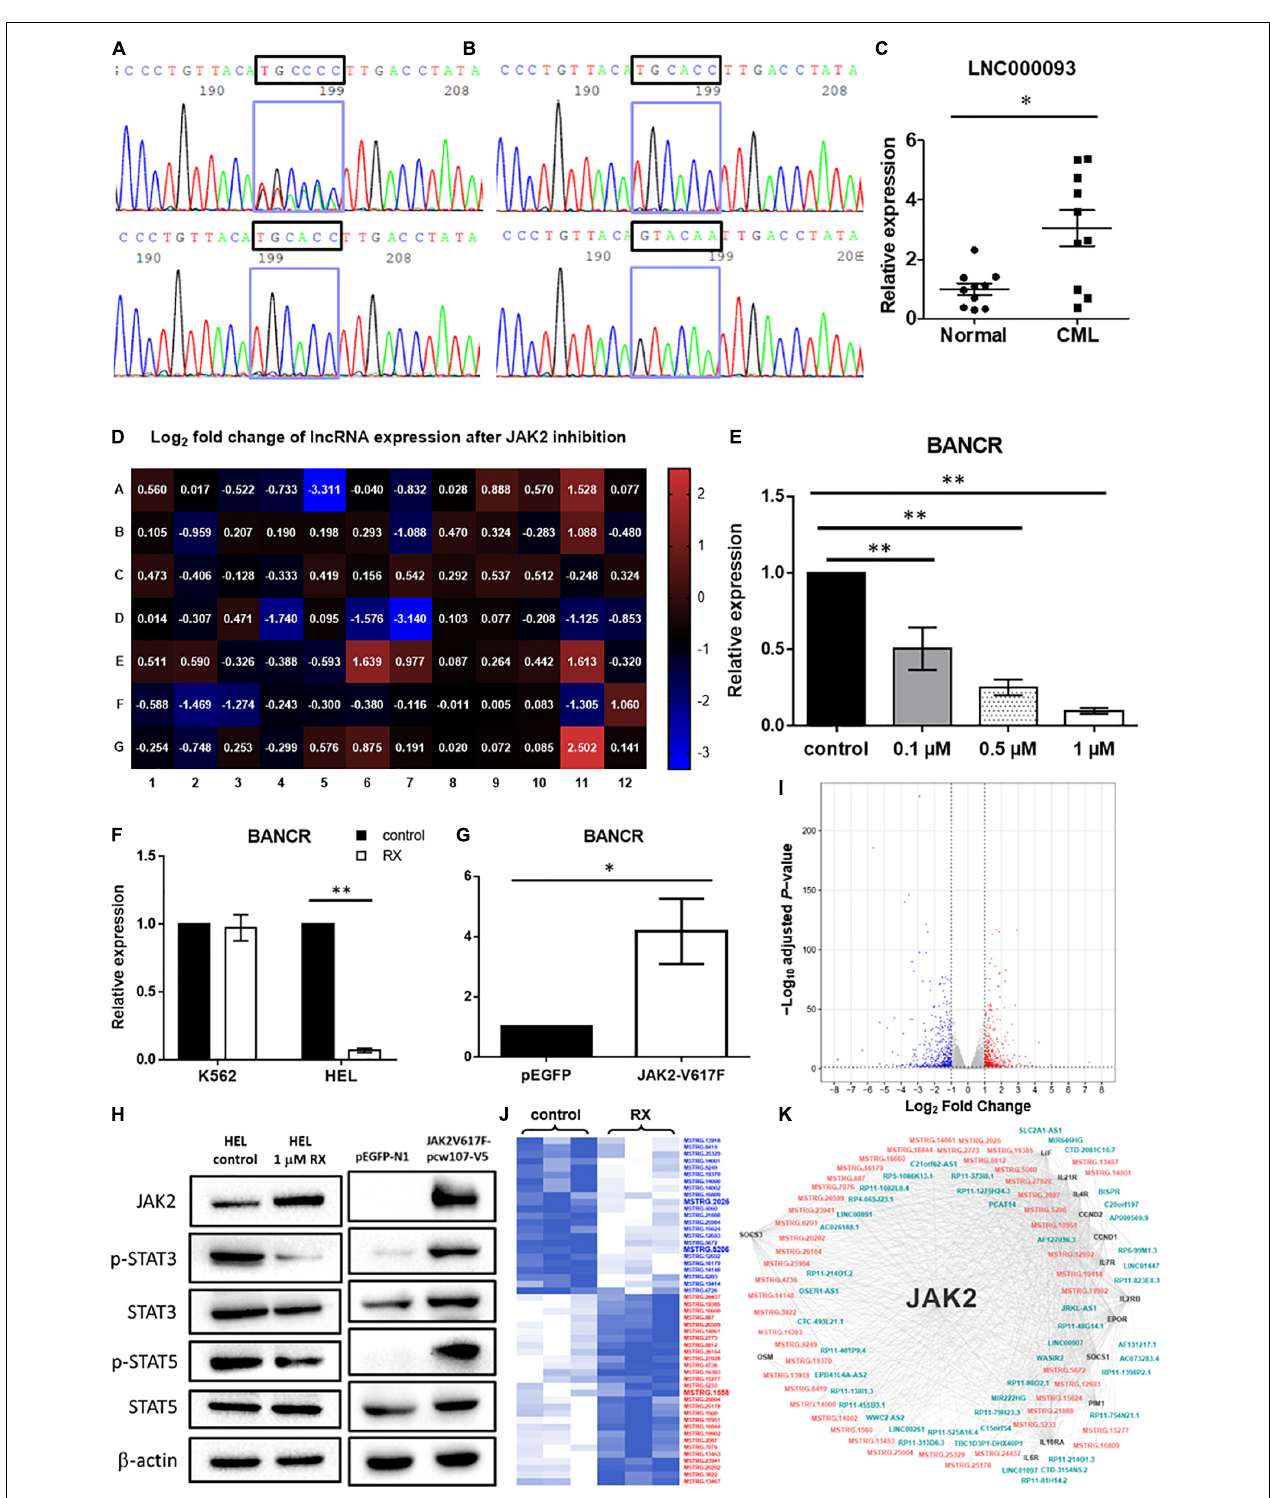
FIGURE 2 | Validation of novel lncRNAs in CML patients and MPN-like cells upon TKI treatment. (A) Cycle sequencing analysis using cDNA as template revealed 2 variants of 6 continuous nucleotide polymorphisms in exon 2 of LNC000093 (upper panel) , while only one variant was shown when using genomic DNA as template (lower panel) . (B) Amplicons from cDNA template were cloned into empty vector and two isolated variants (TGCACC/GTACAA) were selected and evaluated by cycle sequencing. (C) RT-qPCR analysis detected an upregulated expression of LNC000093 in white cells from TKI-sensitive CML patients ( n =